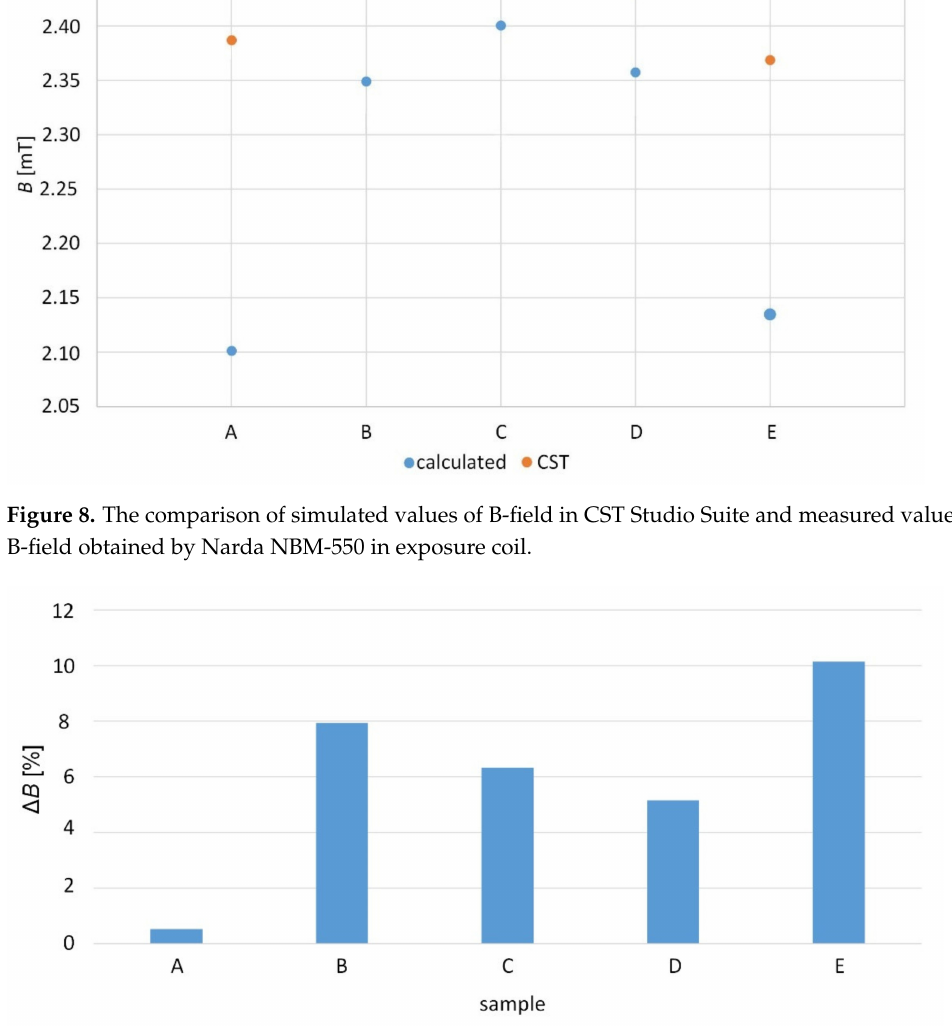
Figure 9. The percentage difference between simulated and measured values of B-field in expo- sure